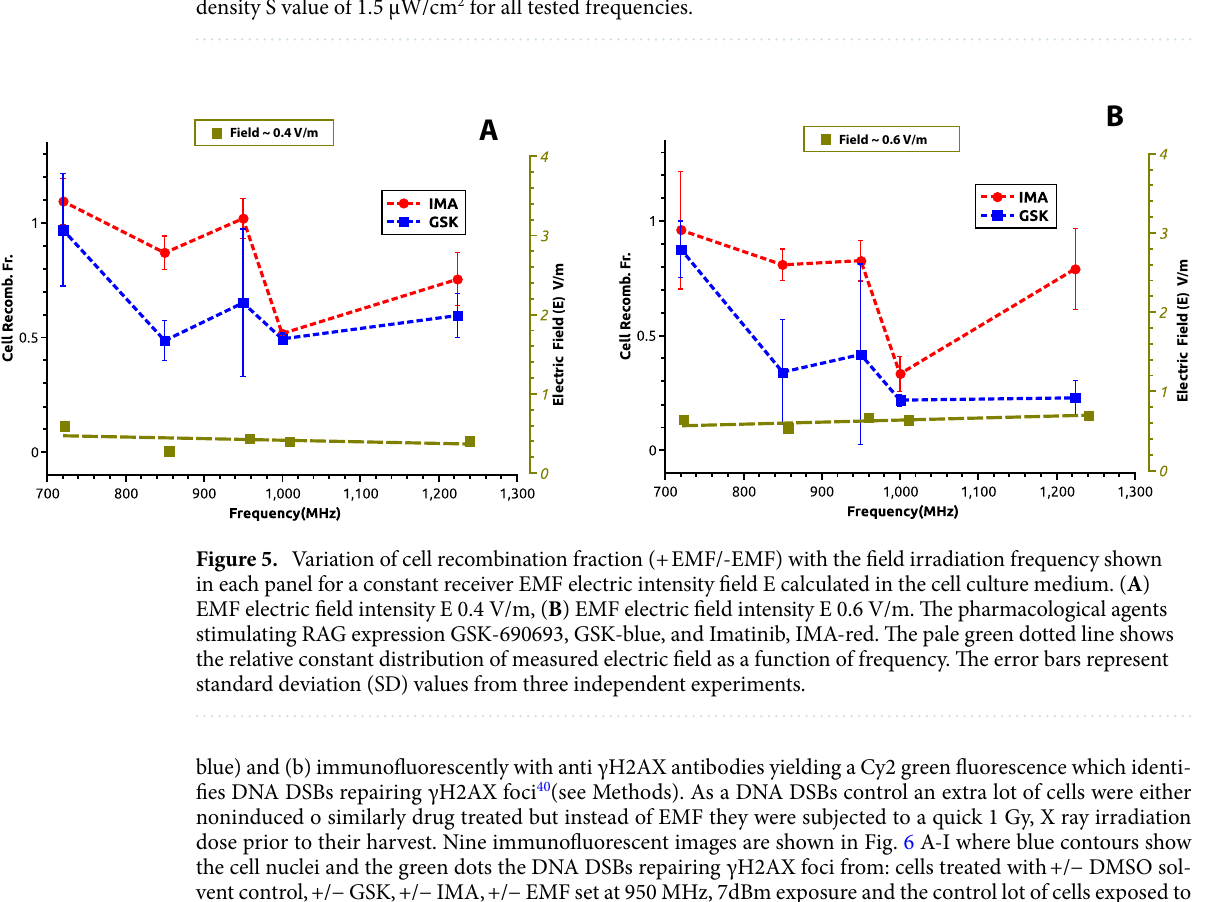
V(D)J recombination the central process in lymphocyte development physiologically generates DNA DSBs dur- ing its course, when cells become susceptible to external sources of DNA damage 5 . Our work tests how pre-B lymphocytes exposure to low dose EMFs of frequencies ranging from 720 MHz to 1.2 GHz, used in utilitarian purpose telecommunication, affects the efficiency of their Igk loci rearrangements. First, we established a setup